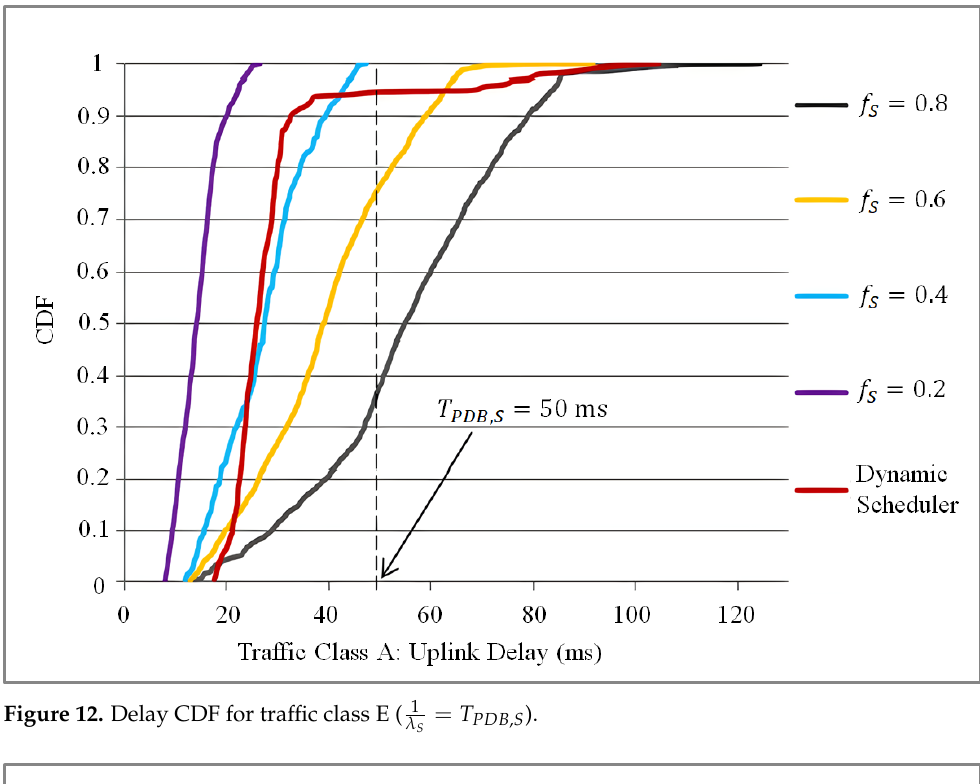
Figure 12. Delay CDF for traffic class E ( 1